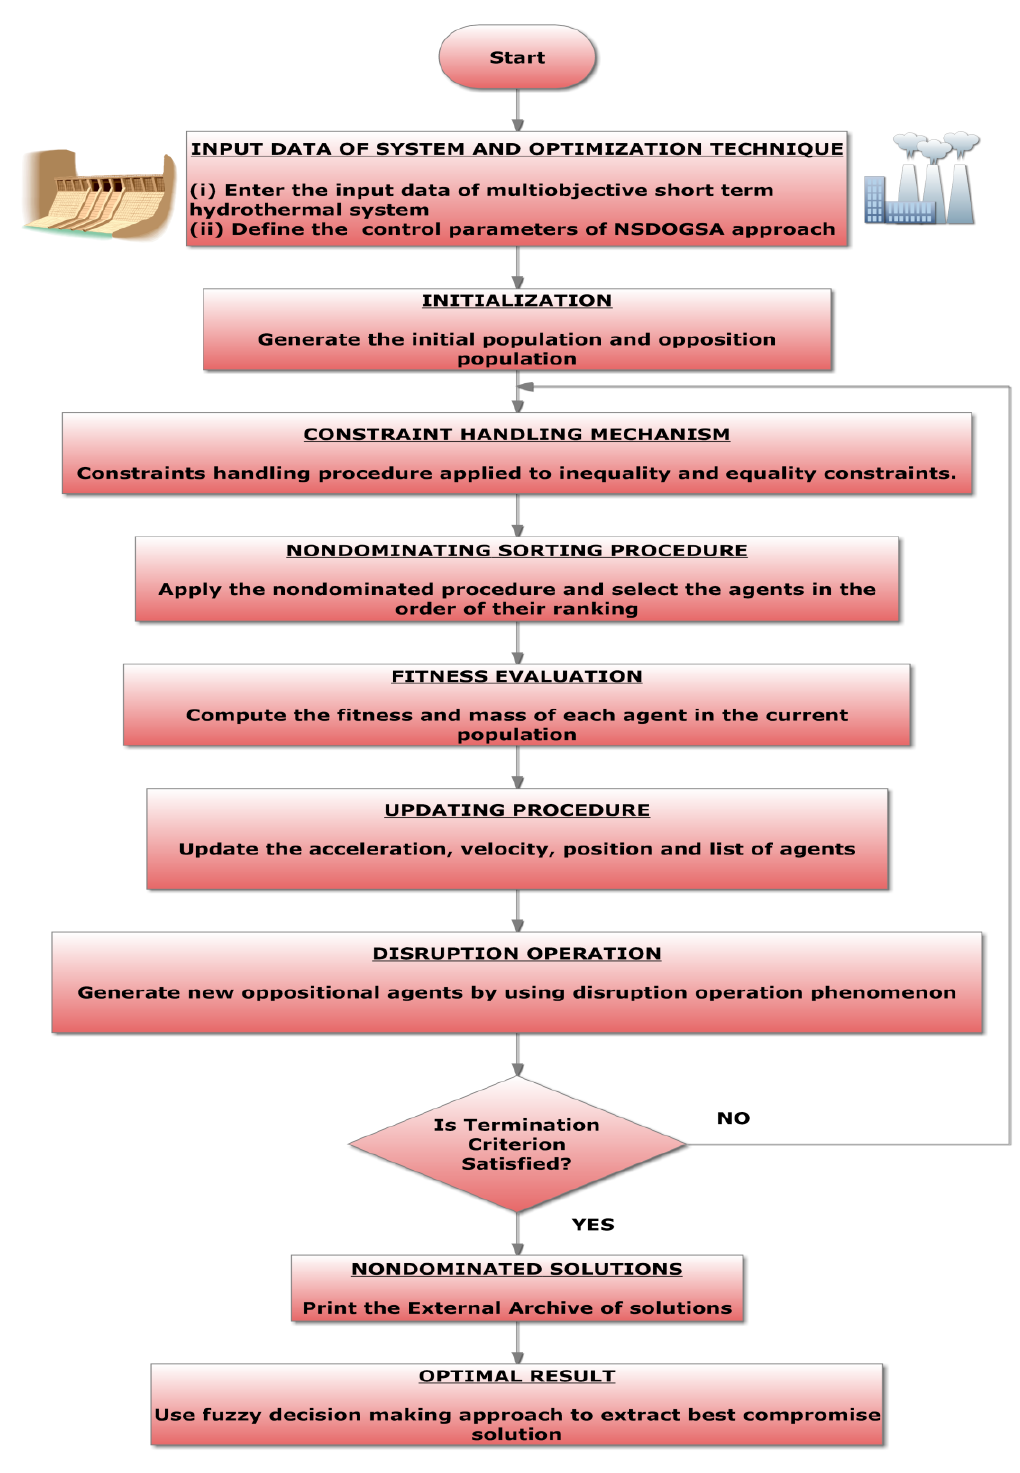
Figure 2. Flowchart of NSDOGSA approach for MSHTS problems.